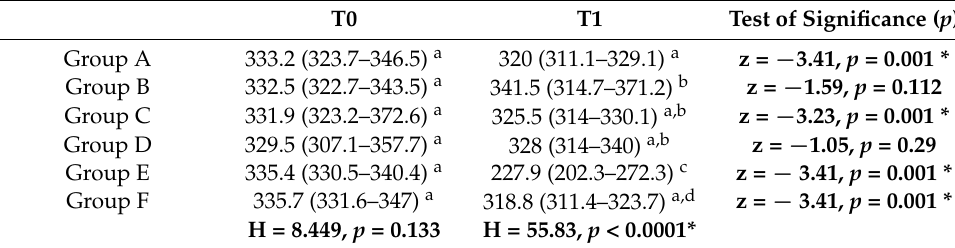
Table 3. Comparison of Knoop hardness (KHN) within and between the study groups. T0 T1 Test of Significance ( p ) Group A 333.2 (323.7–346.5) a 320 (311.1–329.1) a z = − 3.41, p = 0.001 * Group B 332.5 (322.7–343.5) a 341.5 (314.7–371.2) b z = − 1.59, p = 0.112 Group C 331.9 (323.2–372.6) a 325.5 (314–330.1) a,b z = − 3.23, p = 0.001 * Group D 329.5 (307.1–357.7) a 328 (314–340) a,b Group E 335.4 (330.5–340.4)